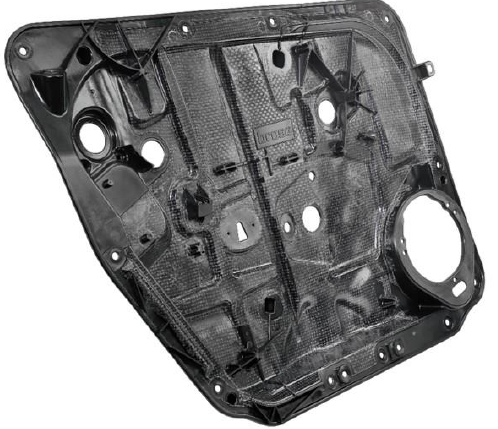
Figure 1. Typical door module carrier hybrid-component made of polypropylene with woven-glass- fiber-reinforced organo sheet and injected with structures (ribs, functional elements, edges, etc.) Reprinted/adapted with permission from Ref. [9]. 2021, ElringKlinger